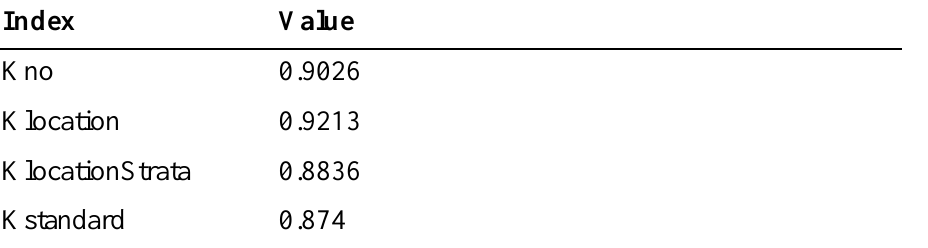
Table 7. The k-index values of the simulated LULC map of